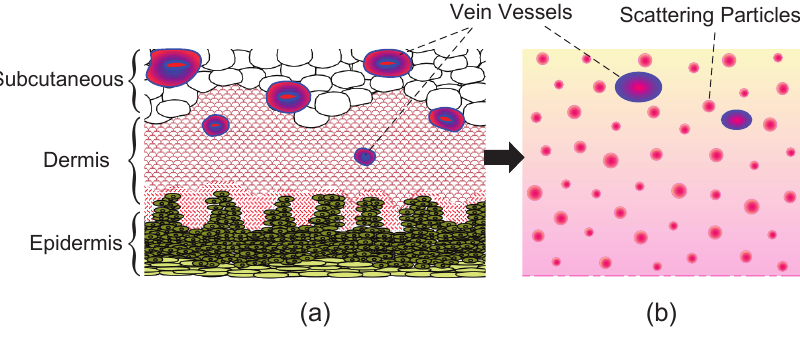
Figure 6. Skin layer modeling. ( a ) Cross-sectional view of human skin. ( b ) Simplified model of finger palm-side skin layer.